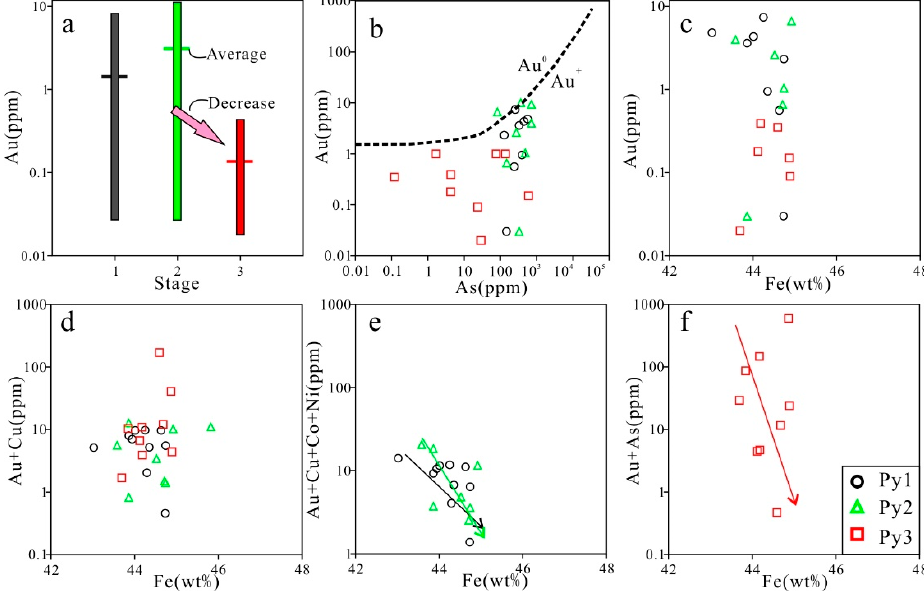
Figure 10. Gold content in different pyrite generations ( a ) and binary correlation diagram of trace elements in different pyrite types from Xiajinbao ( b – f